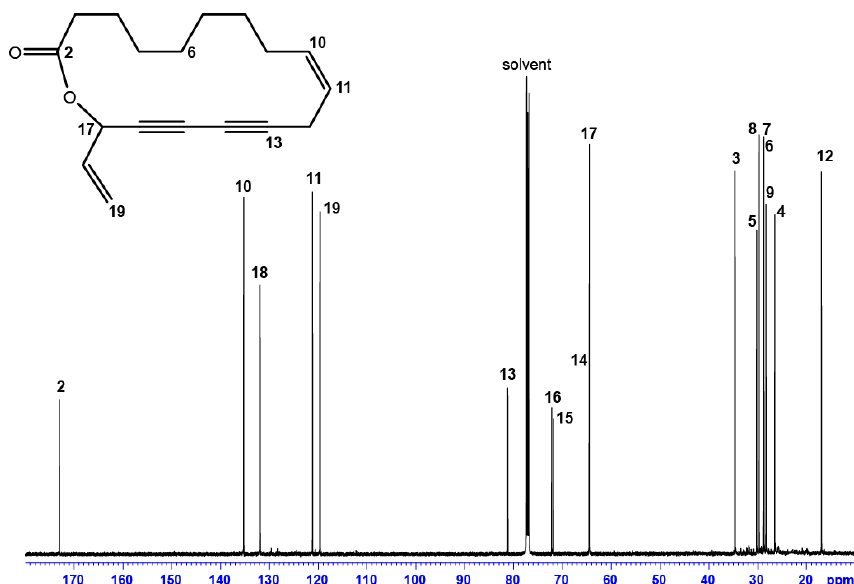
Figure 4. 13 C-NMR spectrum (125.76 MHz in CDCl 3 , 300K) and structure (inset) of Campestrolide 33 (N.B. NMR signal assignments refer to the numbering of the molecule illustrated on the inset; the stereochemistry of 17-CH would be revealed subsequent to the VCD experiments).